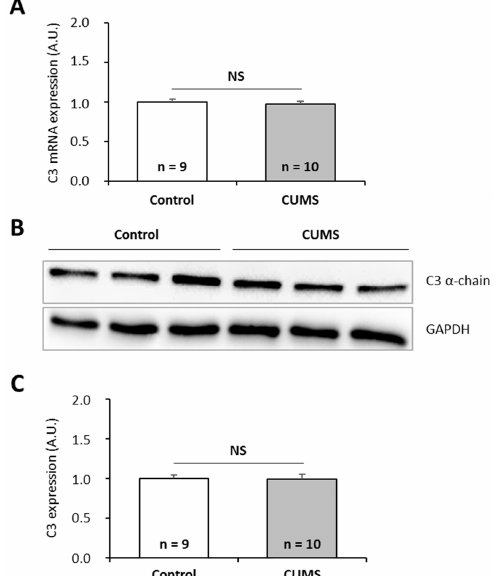
Figure 6. Effects of the CUMS (Chroni Unpredictable Mild psychosocial and environmental Stressors) model, used to simulate socio-environmental stressors encountered during a stay in a space station, on murine complement C3 expression. ( A ) C3 mRNAs were quantified by RT-qPCR. ( B, C ) C3 proteins were quantified by western blotting. Western blot results were visualized by chemiluminescence, analyzed by densitometry, and normalized to GAPDH. Relative values obtained with control mice reared under normal housing conditions were set to one in ( A ) and ( C ). Results are expressed as means ± SEM. “A.U.” stands for “arbitrary units”. No differences were found using student’s t -tests. NS., no statistical difference.